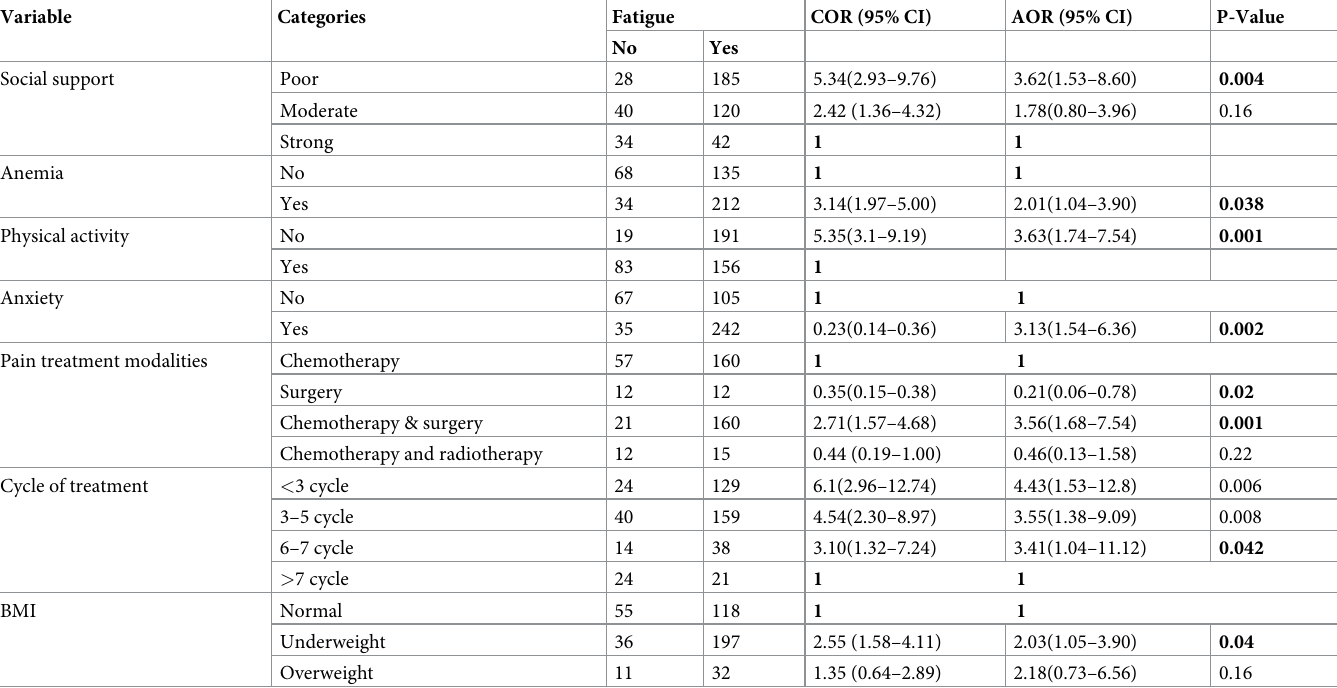
Table 6. Factors associated with fatigue among adult cancer patients receiving cancer treatment at oncology unit in Amhara region, Ethiopia, 2022 (N =